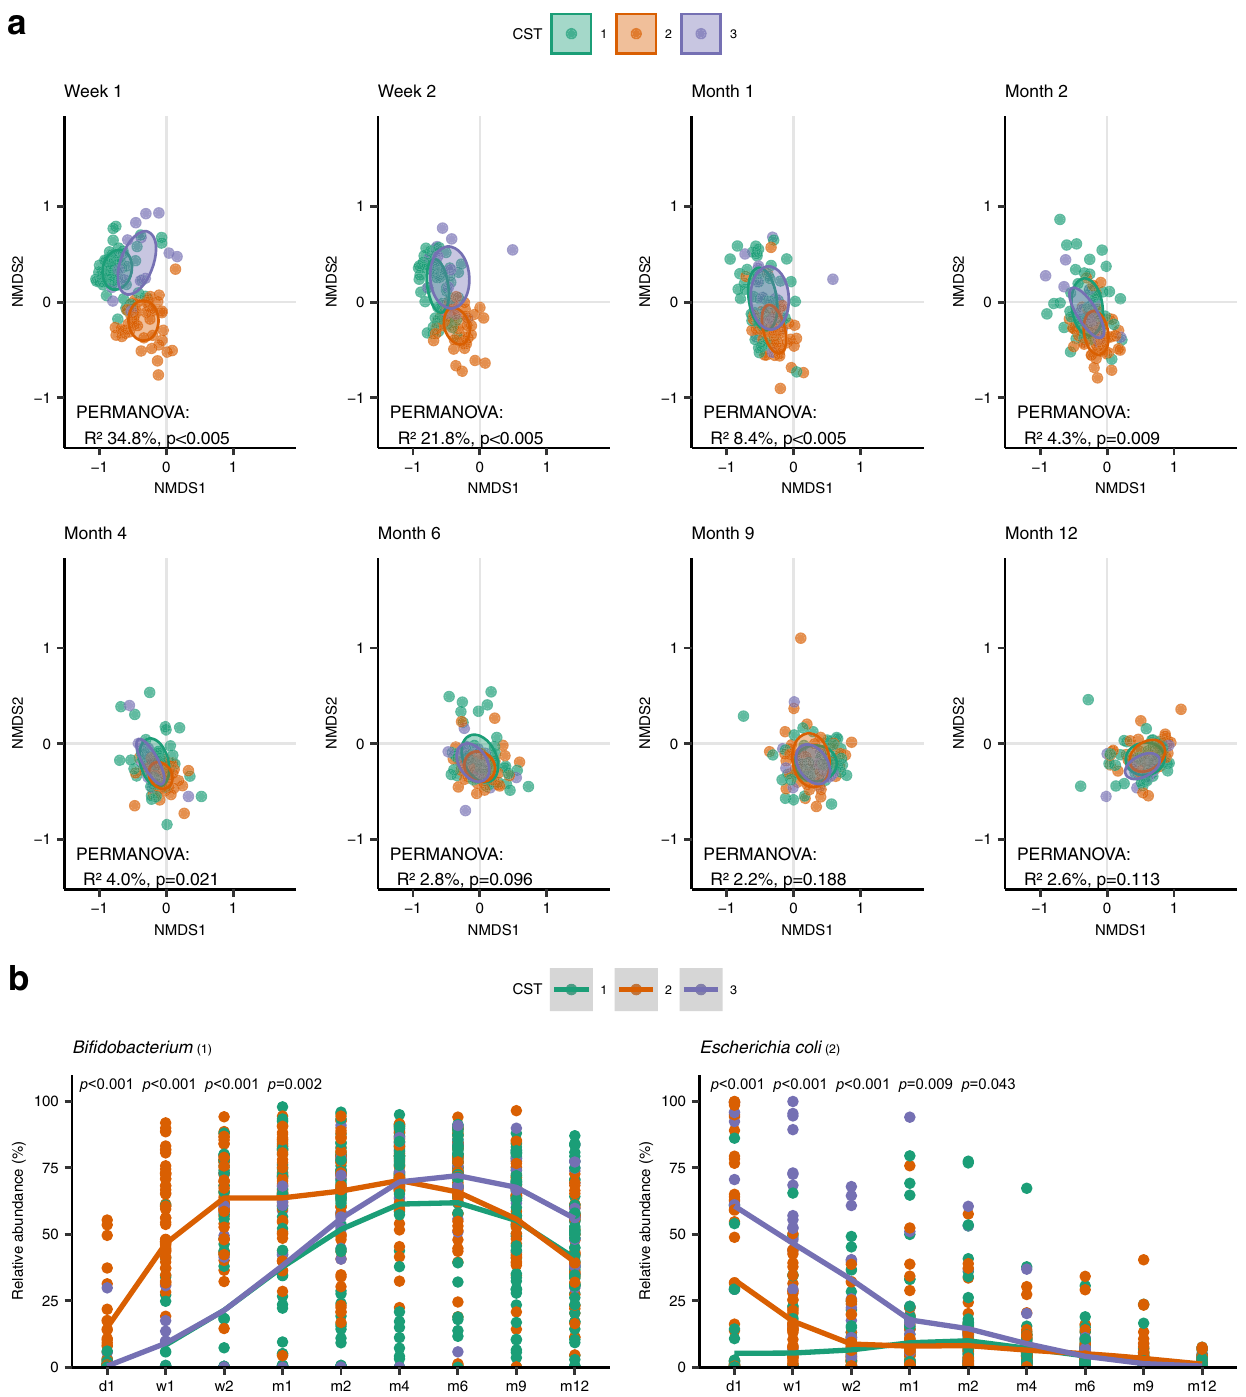
variance (PERMANOVA) and corresponding p -values are shown in the plots. b Relative abundances of Bi fi dobacterium (1) (left) and Escherichia coli (2) (right) overtimeaccording to week1 CST. Signi fi canceof differences according to week 1 CST was assessed using Kruskal – Wallis tests. Source data are provided in the Source Data fi